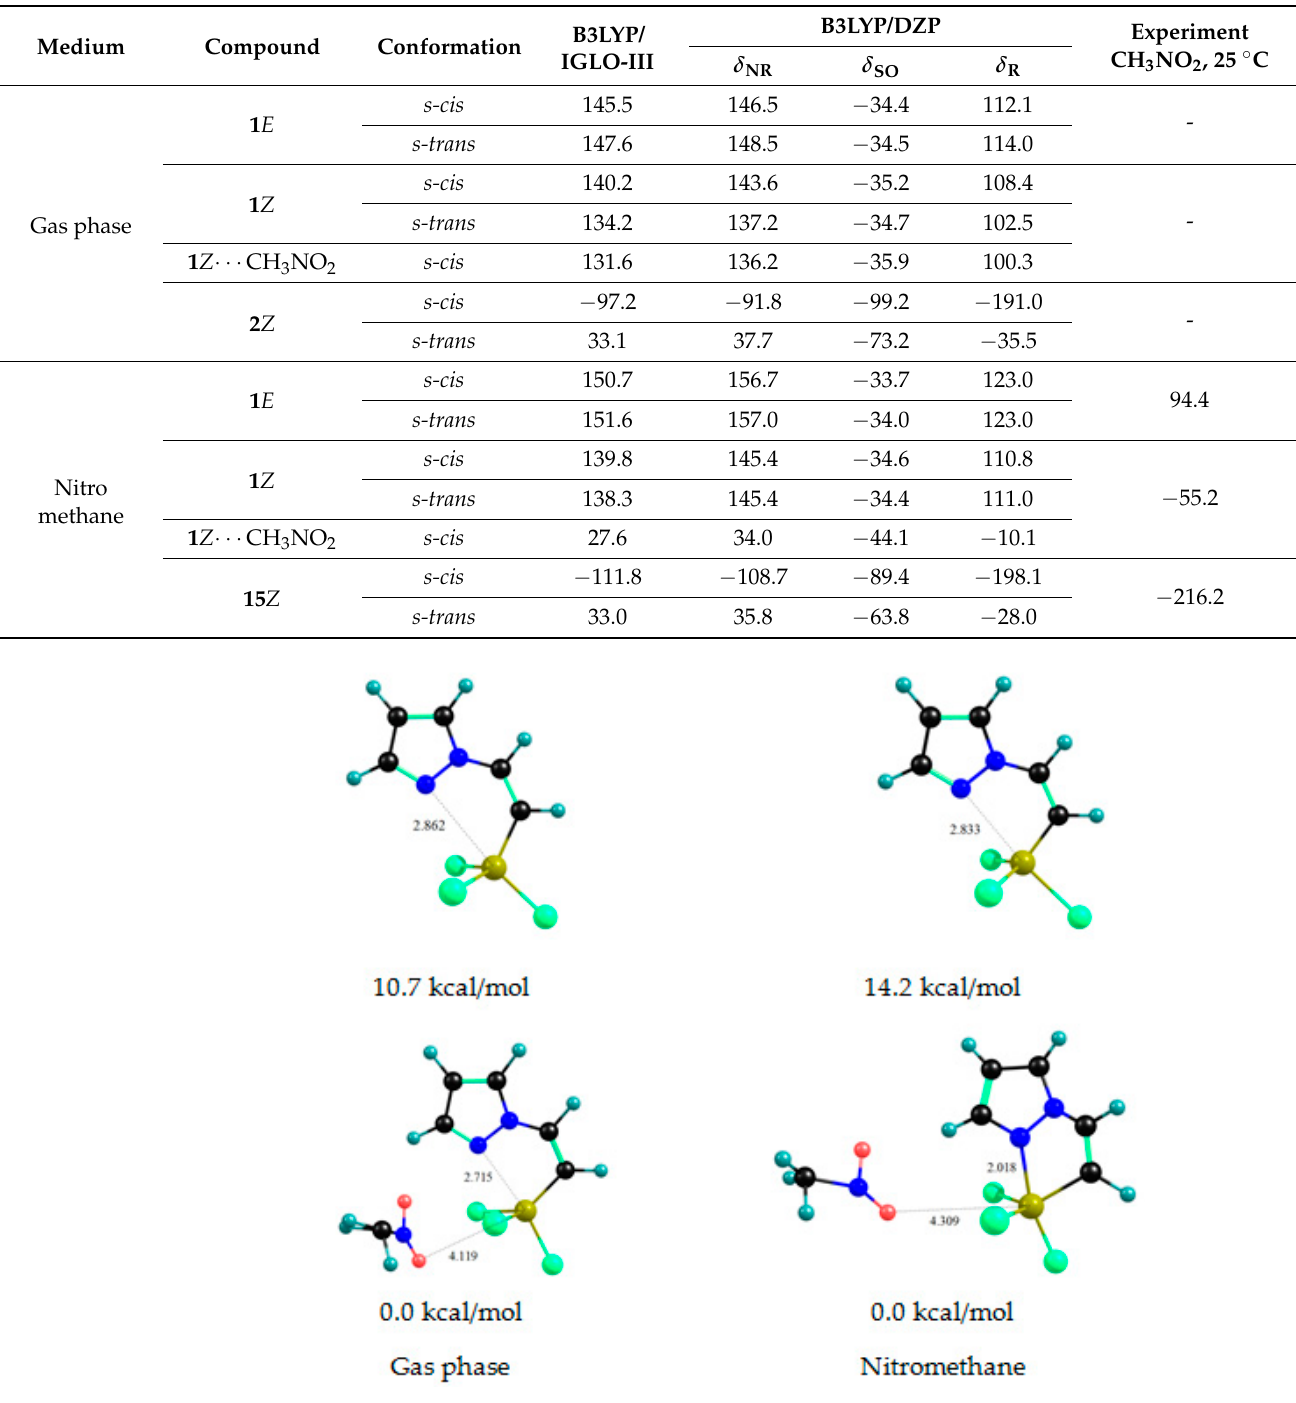
Figure 2. Preferred conformations and relative total energies (kcal/mol) of compound 1 Z and its complex with nitromethane molecule, calculated by the B3LYP/6-311G(d,p) method and taking into account the solvation effects within the polarizable continuum model. Bond lengths are given in Å.